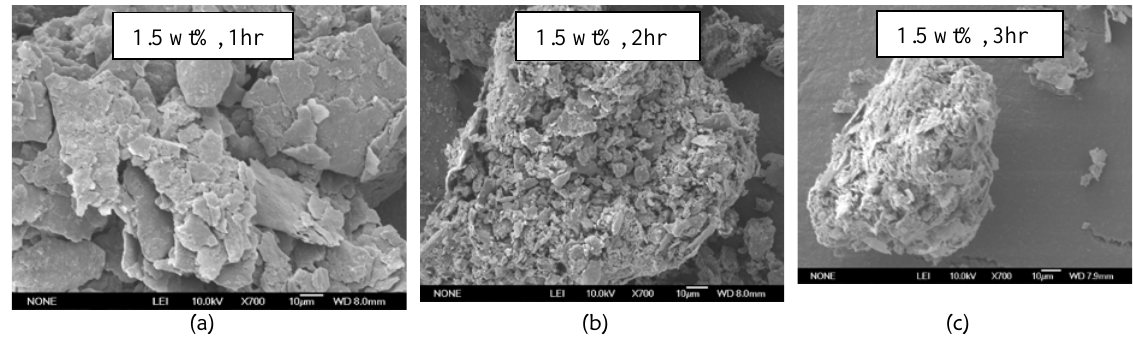
Figure 3: Microstructure of 1.5 wt% of CNT at 250 rpm for different ball milling